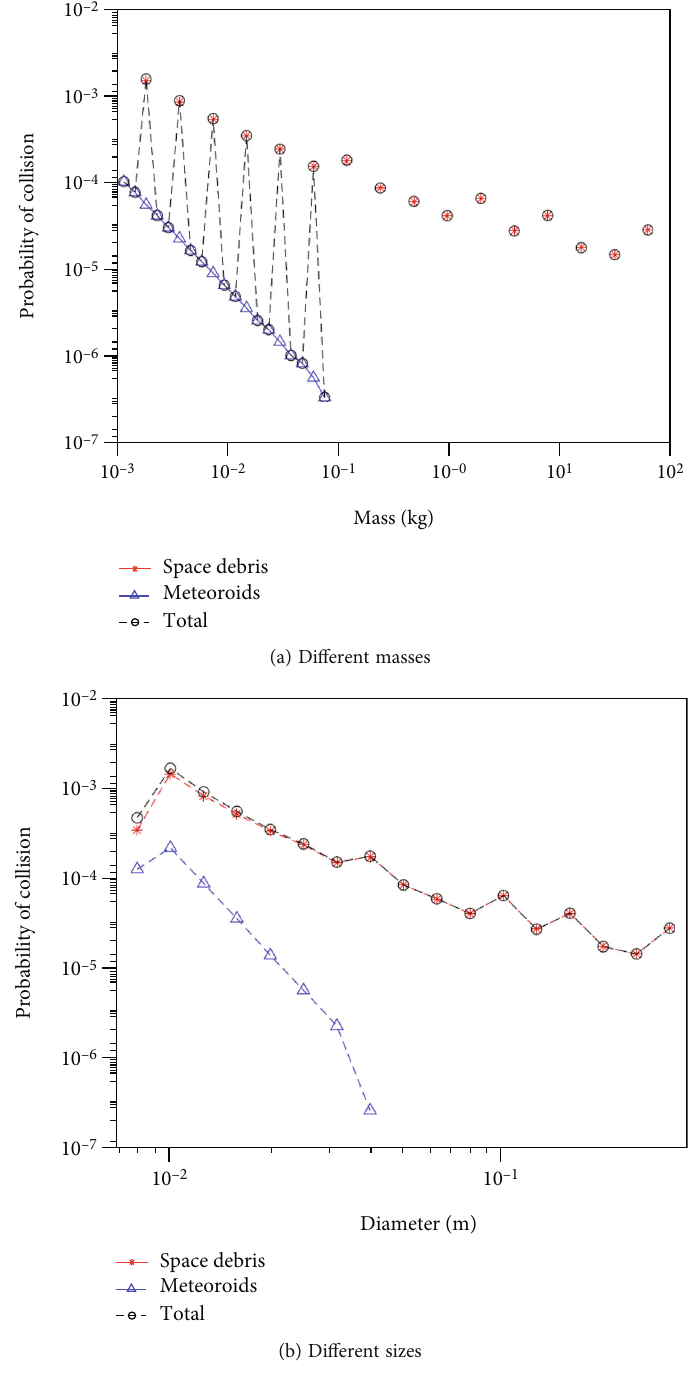
Figure 12: The calculation of object collision